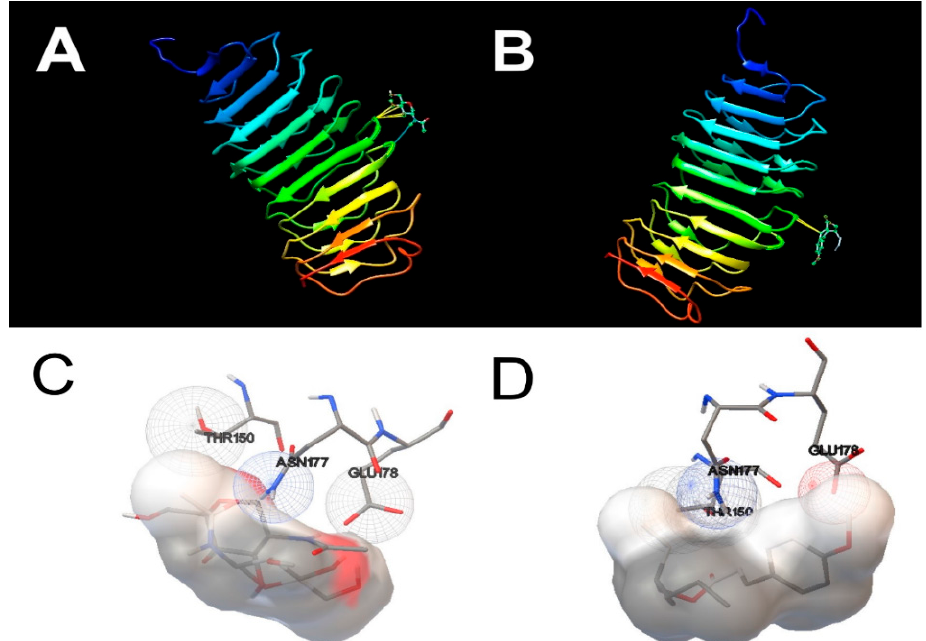
Figure 9. Docking views of the complex between the ligands with TSHR using Quimera 1.15 software. ( A , B ) show the 3D representations of the interactions and preferred conformation between natural ligand 2-acetamido-2-deoxy-beta- D -glucopyranose (NAG) and octylmethoxycinnamate (OMC), respectively, within TSHR active centre. ( C , D ) show the interactions between natural ligand 2-acetamido-2-deoxy-beta- D -glucopyranose (NAG) and octylmethoxycinnamate (OMC), respectively, to the amino acid residues in the TSHR active centre.